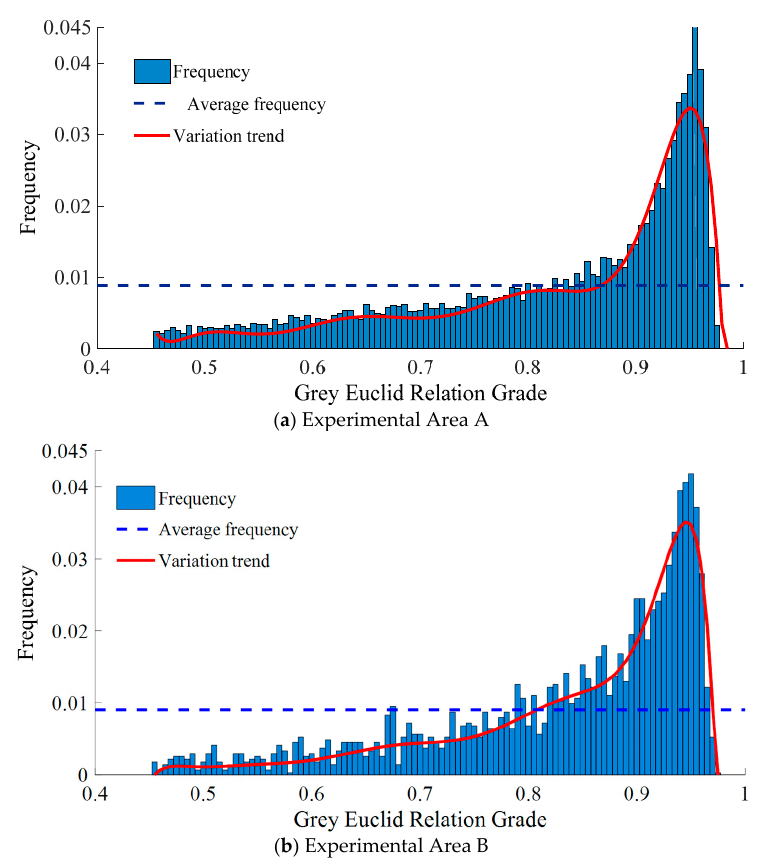
Figure 7. Frequency histogram of the Grey Euclid Relation Grade.